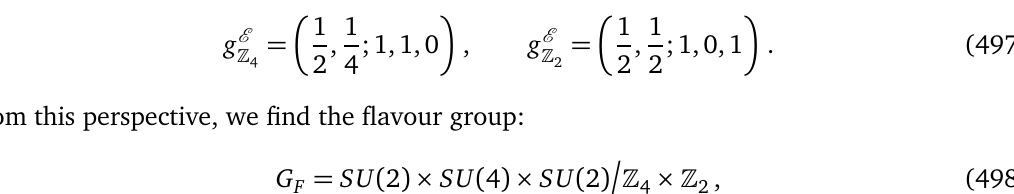
Figure 23: Fundamental domains for configurations on the CB of D